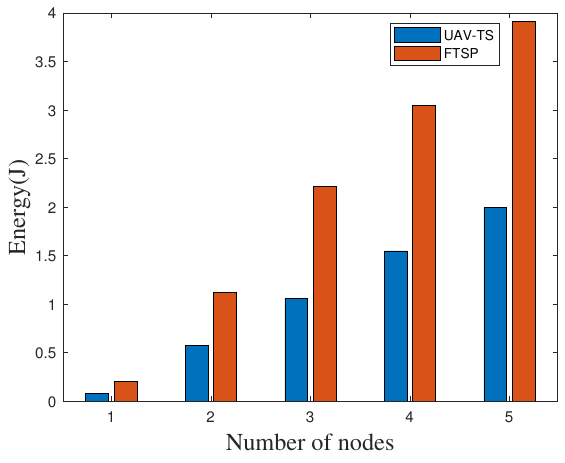
Figure 16. Comparison energy consumption with FTSP